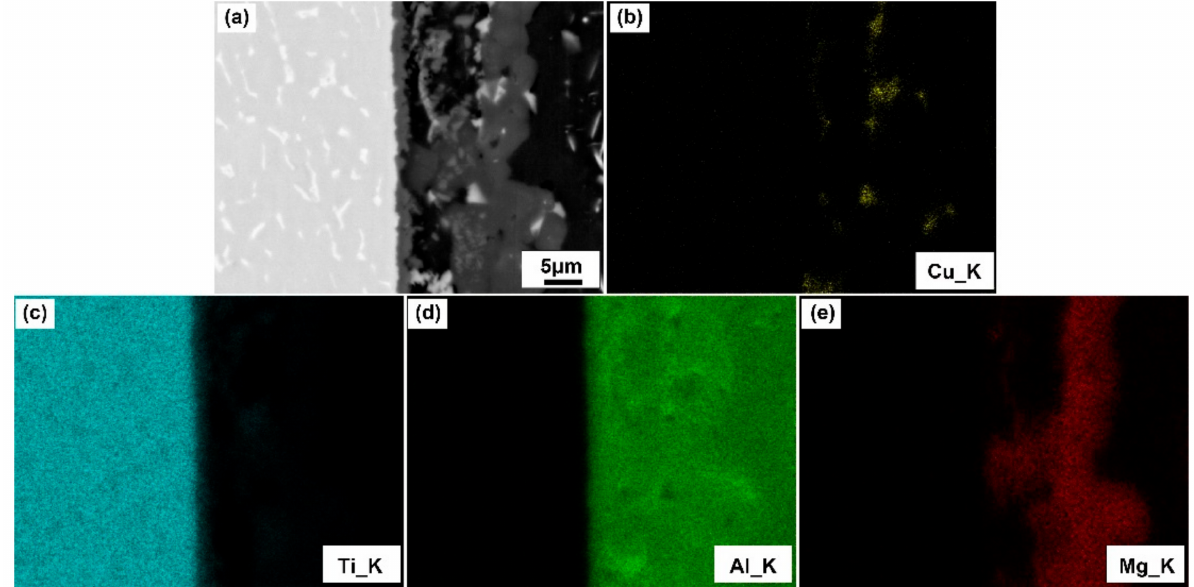
Figure 3. Elemental distribution of TC4/Cu layer/Al7075 brazed joint brazed at 600 ◦ C for 30 min. ( a ) BSE image of the typical brazed joint and the elemental distribution of ( b ) Ti; ( c ) Al; ( d ) Cu; ( e )